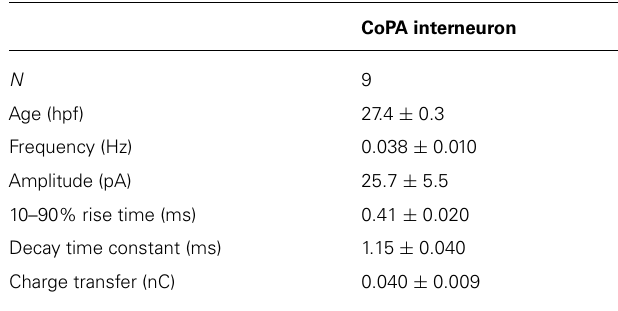
Table 1 | Properties of glycinergic mPSCs in spinal neurons from 26 to 29 hpf embryos.